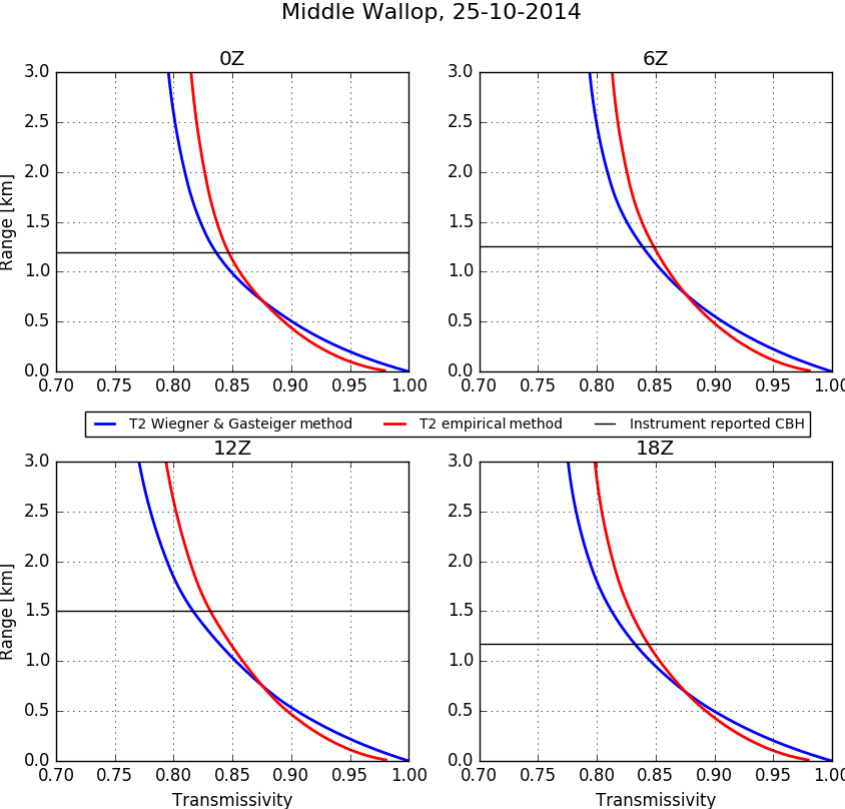
Figure 5. Comparison of water vapour transmission correction methods using ECMWF water vapour density profiles for 25 October 2014 at Middle Wallop, England. In blue, the transmissivity is calculated using WAPL (Wiegner and Gasteiger, 2015) and in red the transmissivity has been calculated using the empirical function shown in Fig. 4. The black lines show the instrument-reported cloud base height at that time.